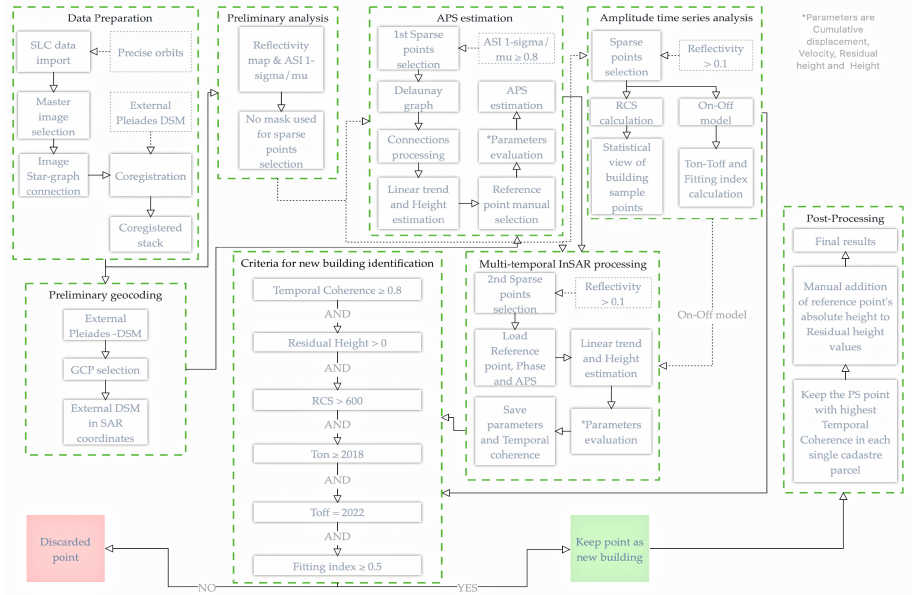
Figure 3. Flowchart of the proposed